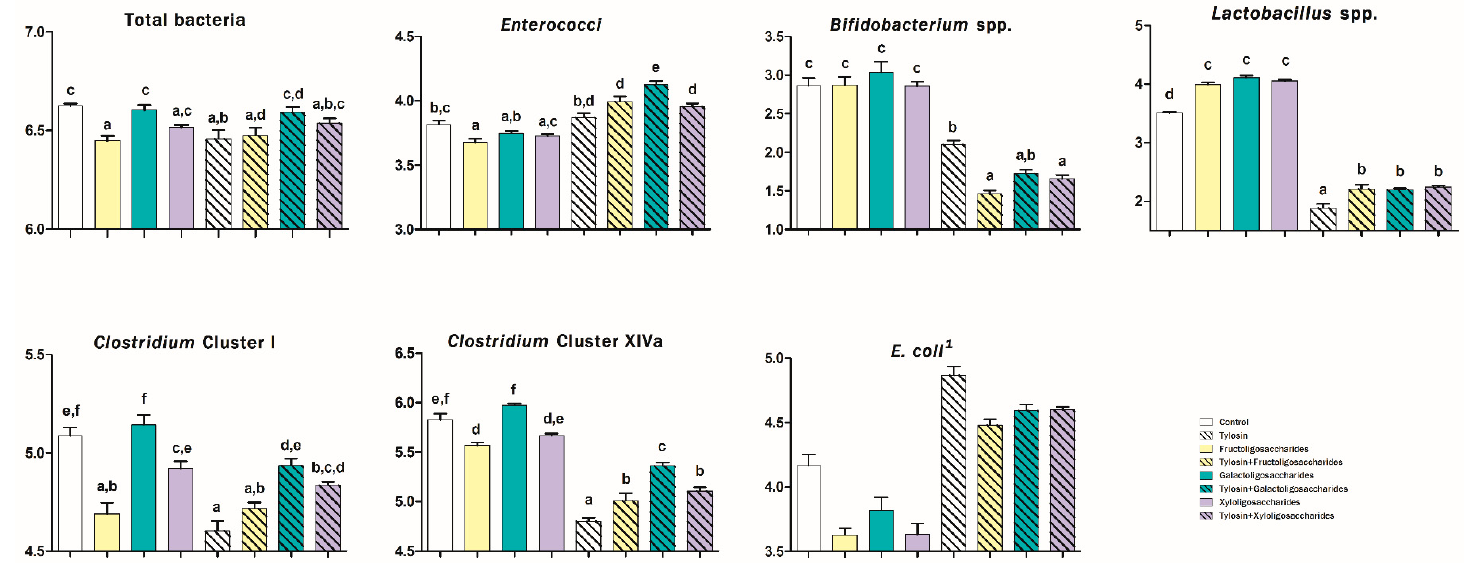
Figure 2. Microbial analysis (log 10 copies DNA/ng DNA) after 24 h of an in vitro incubation of canine fecal inoculum with a control diet supplemented with some prebiotics and/or tylosin tartrate. Values are the means of five bottles per treatment. According to Two-way ANOVA (Newman-Keuls test as post hoc): 1 fructooligosaccharides, galactooligosaccharides and xylooligosaccharides differ from control ( p < 0.001). According to One-way ANOVA (Tukey’s test as post hoc): different letters indicate significant differences ( p < 0.05).